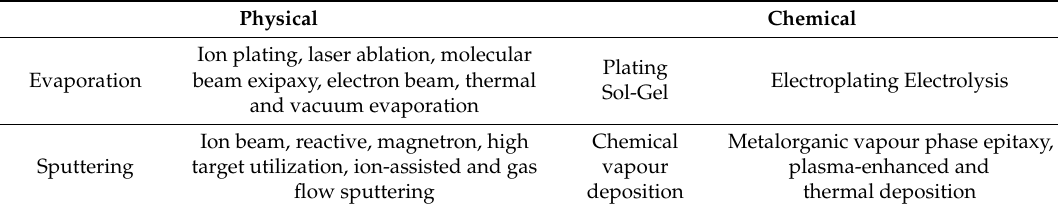
Table 7. The division of deposition techniques for the preparation of silver nanolayers